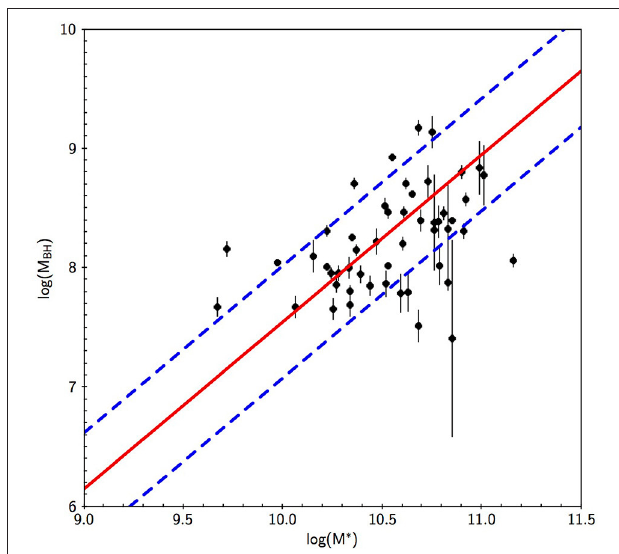
FIGURE 4 | Correlation between quasar virial black hole mass and the total stellar mass of their host galaxies as derived from SED fitting. Despite the large scatter the relation is similar to that obtained by Reines and Volonteri (2015) for inactive galaxies and bulges (red solid line). The 1 σ uncertainties are indicated by blue dashed